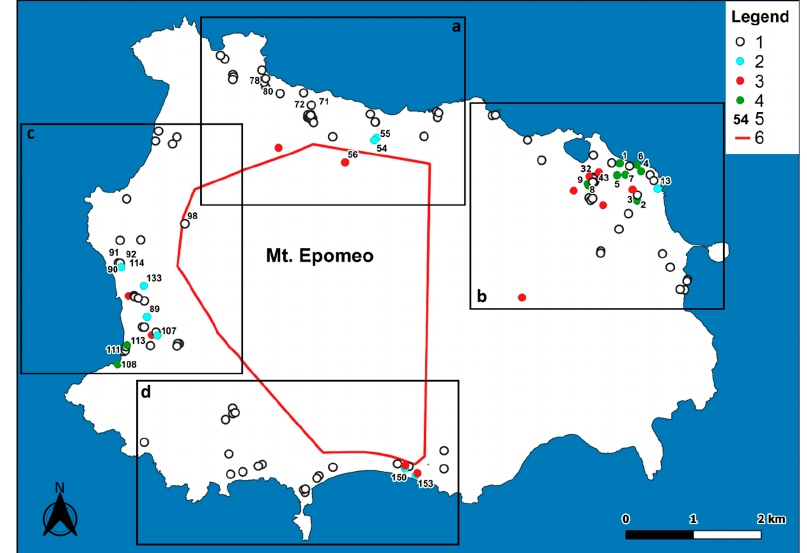
thematic maps: ( a ) N area, ( b ) NE area, ( c ) W area, ( d ) SW area). Legend: (1) pumping test wells, (2)